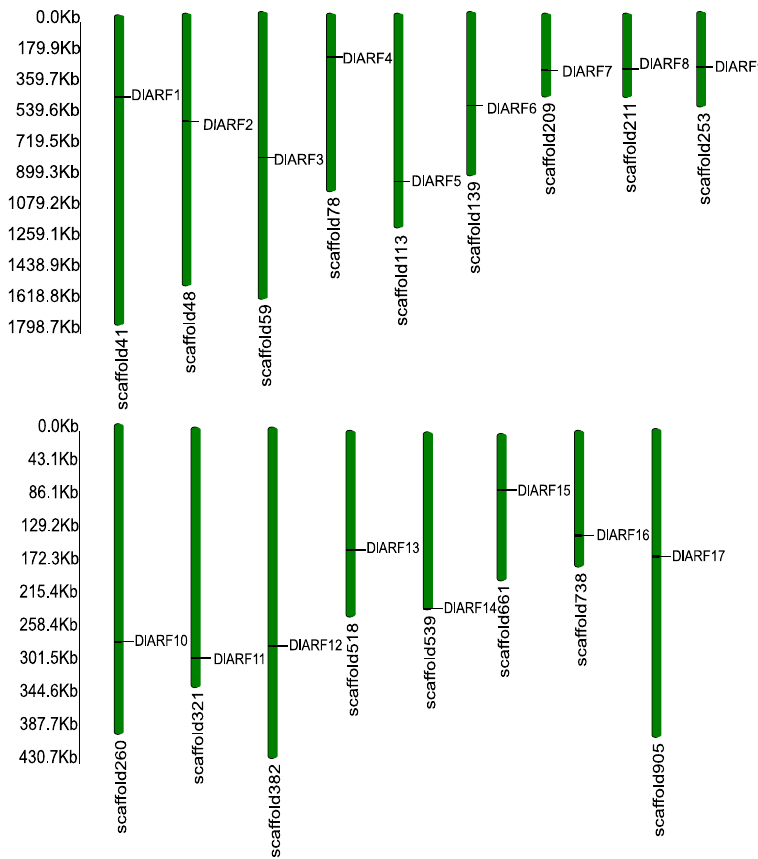
Figure 1. The location in scaffold of Dimocarpus longan auxin response factor (DlARF) family. The scaffold numbers and size are indicated at the top and bottom of each bar, respectively. The scale is in kilo bases (kb).